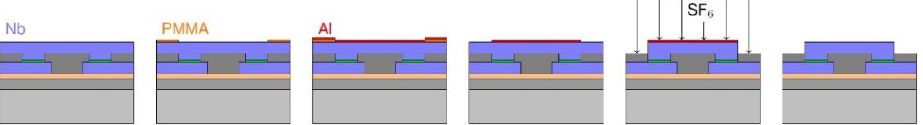
Figure 3. Layer scheme of the nanoSQUID fabrication process to define the first Nb wiring layer. After MSD of the 200 nm Nb layer, the Al hard mask is patterned by a positive resist mask and a subsequent lift-off process and the first Nb wiring layer is etched with ICP RIE using SF 6 . Subsequently, the Al mask is removed by using a wet etching step.